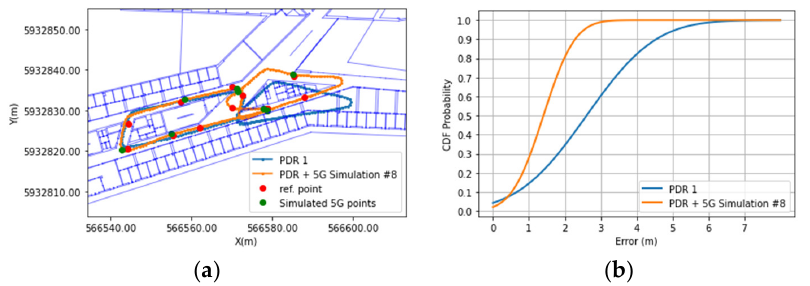
Figure 9. The proof of concept in fusion of 5G and PDR using eight simulated points: ( a ) Trajectories; and ( b ) Error vs. CDF probability of mentioned methods.